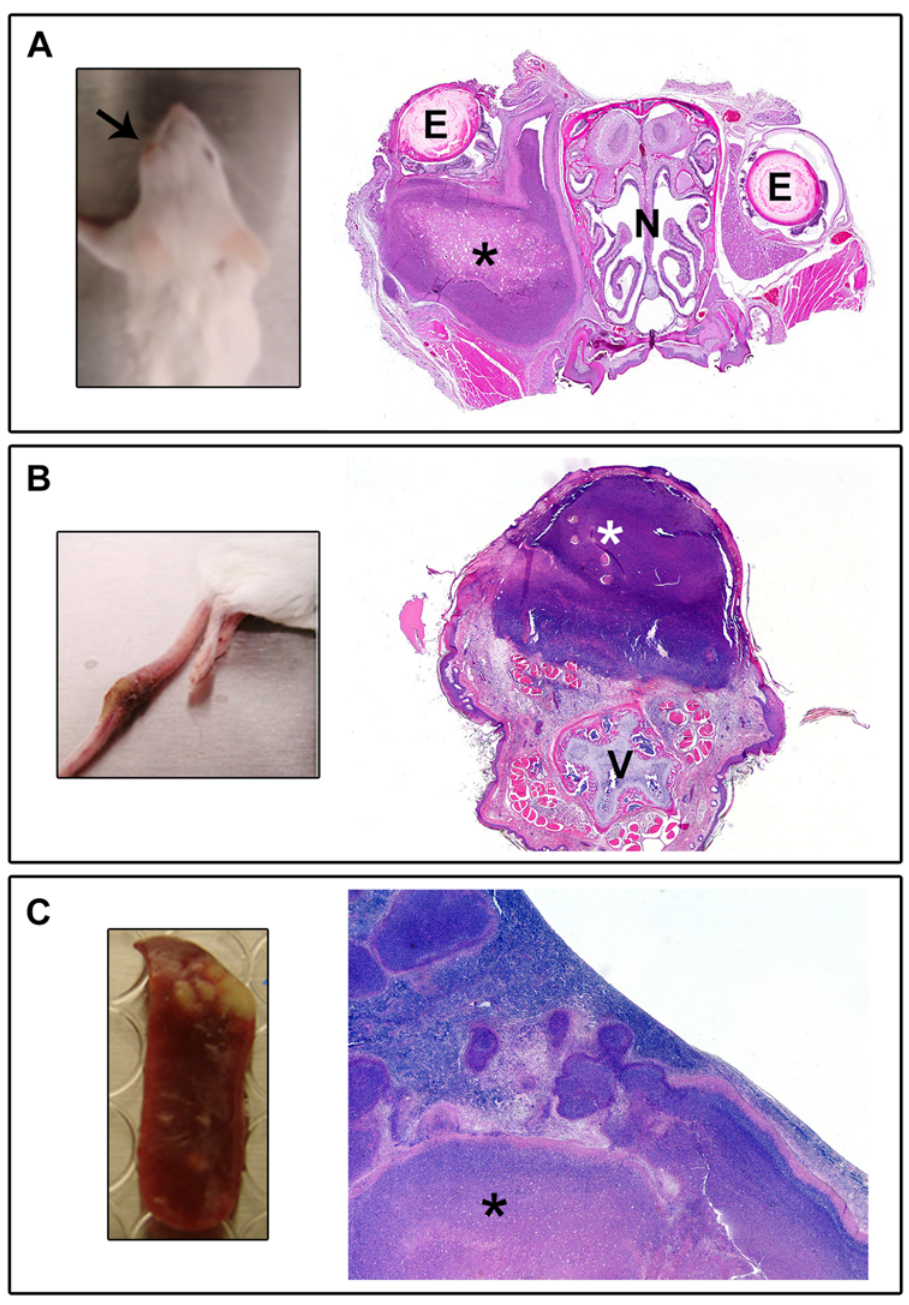
Fig 4. Several noteworthy clinical/gross observations and their histopathological correlates. A. Swelling of or around the eye (white arrow). Histologic evaluation revealed abscesses and pyogranulomatous inflammation filling the retro-orbital space causing the globe of the eye (E) to protrude from the socket (BALB/c mouse challenged with 4.2 x 10 4 CFU 1106a, H&E 2X). The nasal cavity (N) is also marked for orientation. B. Large swellings on the tail (often seen in conjunction with hind limb swelling and/or paralysis). Histologic evaluation revealed pyogranulomatous inflammation from the haired skin of the tail extending into adjacent bone, skeletal muscle, and adipose tissue (BALB/c mouse challenged with 1.4 x 10 4 CFU K96243, H&E 20X). The tail vertebra (V) is denoted for orientation. C. Firm white nodules in the spleen. Histologic evaluation revealed marked pyogranulomatous inflammation and necrosis (identified with an * ) in the spleen which effaces normal white and red pulp (BALB/c mouse challenged with 9.0 x 10 2 MSHR668, H&E